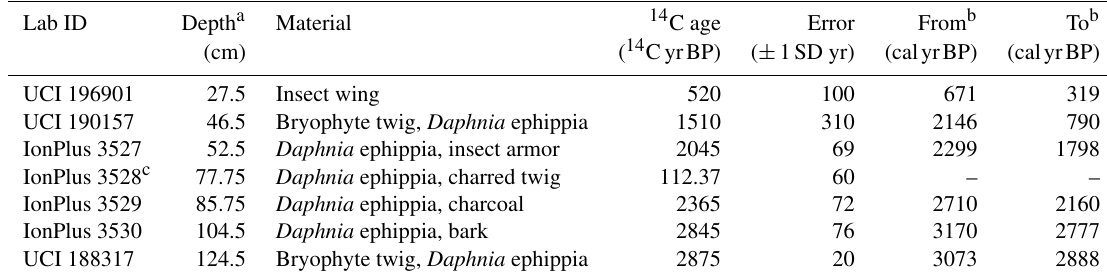
∗ Indicates the observer agreement as the range in the percentage difference from the mean. Table 3. Uncalibrated and calibrated radiocarbon